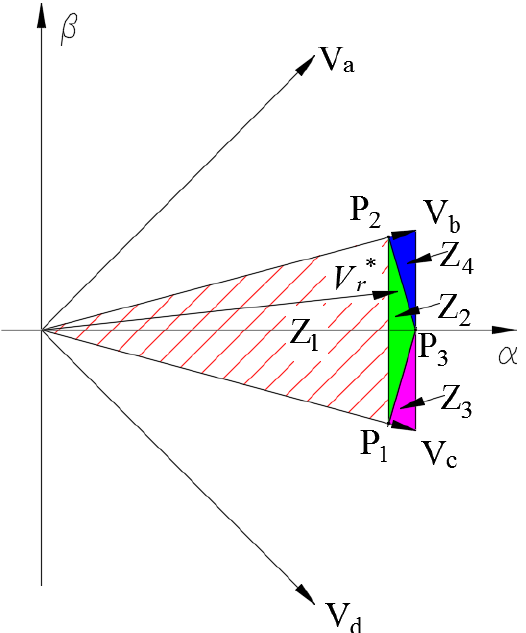
Figure 4. Divided regions of the first sector.